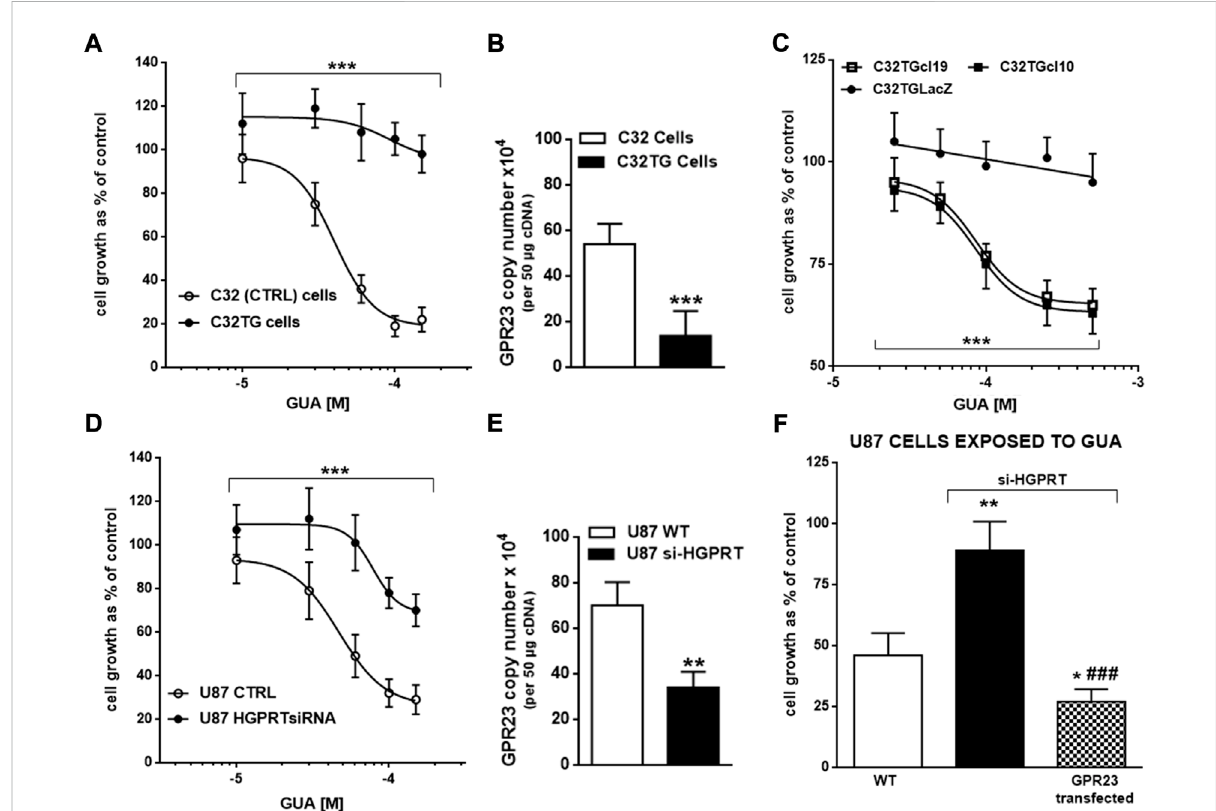
FIGURE 5 Involvement of HGPRT enzyme in GUA-mediated cell growth inhibition. Concentration-response curves of GUA-mediated antiproliferative effect in (A) C32 melanoma cells expressing normal (WT, wild type) or inactive HGPRT form (C32TG cells) or (B) U87 wild type cells (WT) or silenced for HGPRT (U87 HGPRTsiRNA). Furthermore, the mRNA expression of GPR23 was evaluated in C32 (C) and U87 (D) cells by qRT-PCR. Finally, (E) C32TG cells with mutated HGPRT were transfected to overexpress GPR23 (C32TGcl19 and C32TGcl10) or LacZ construct (C32TGLacZ). Likewise, (F) U87WTorHGPRTsilencedcellsweretransfectedtooverexpressGPR23.Afterwards,cellswereexposedtoGUAasdescribedabove.For theentire duration of experiments, C32TG, -LacZ cellsand GPR23 overexpressing clones werecultured inthemedium without thioguanine. Results are expressed as the percentage of cell growth evaluated by the MTT assay in untreated cells (control) in (A,B,E,F) Panels. In all panels, values represent the mean ± SD of 3 independent experiments. Statistical signi fi cance: *** p < 0.001 vs. C32 or U87 WT cells (as for Panels (A,B) ) or vs. C32TGLacZ cells (only as for Panel (E) (ANOVA two-way test); ** p < 0.01 and *** p < 0.001 vs. C32 cells with normal HGPRT form or U87 WT